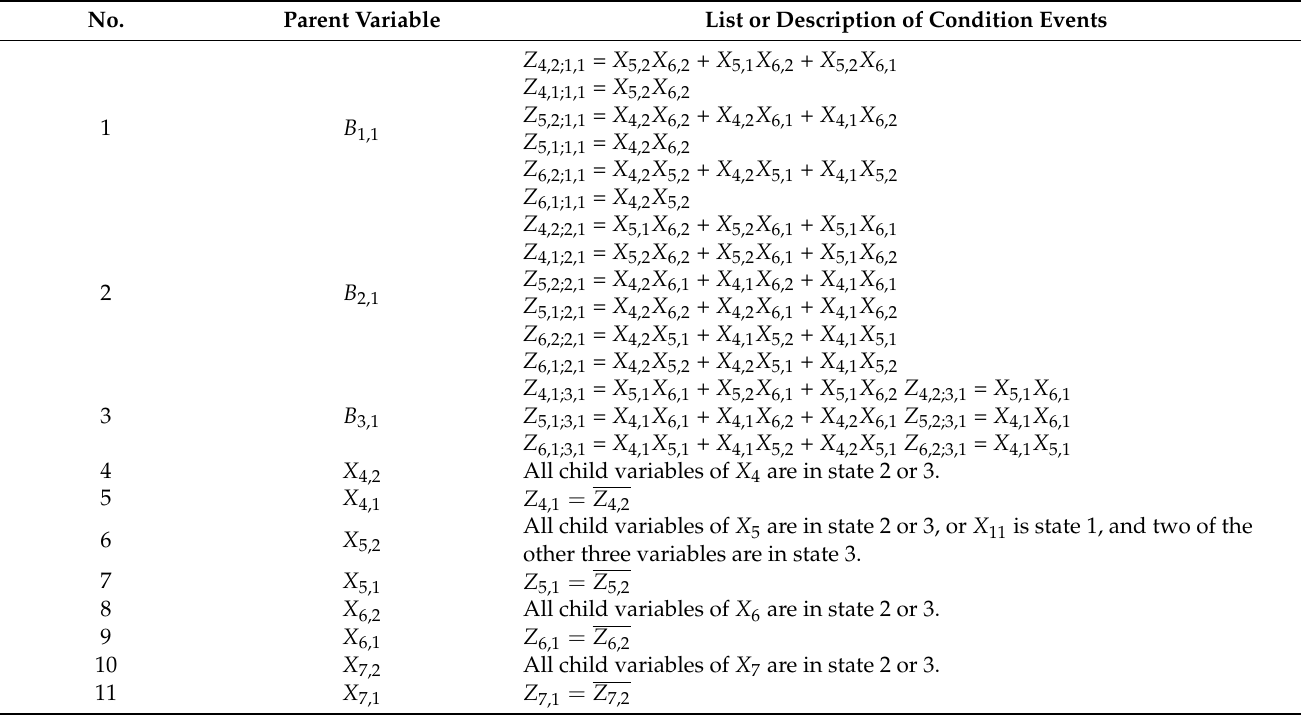
Table 4. Condition event list of the shale-gas evaluation